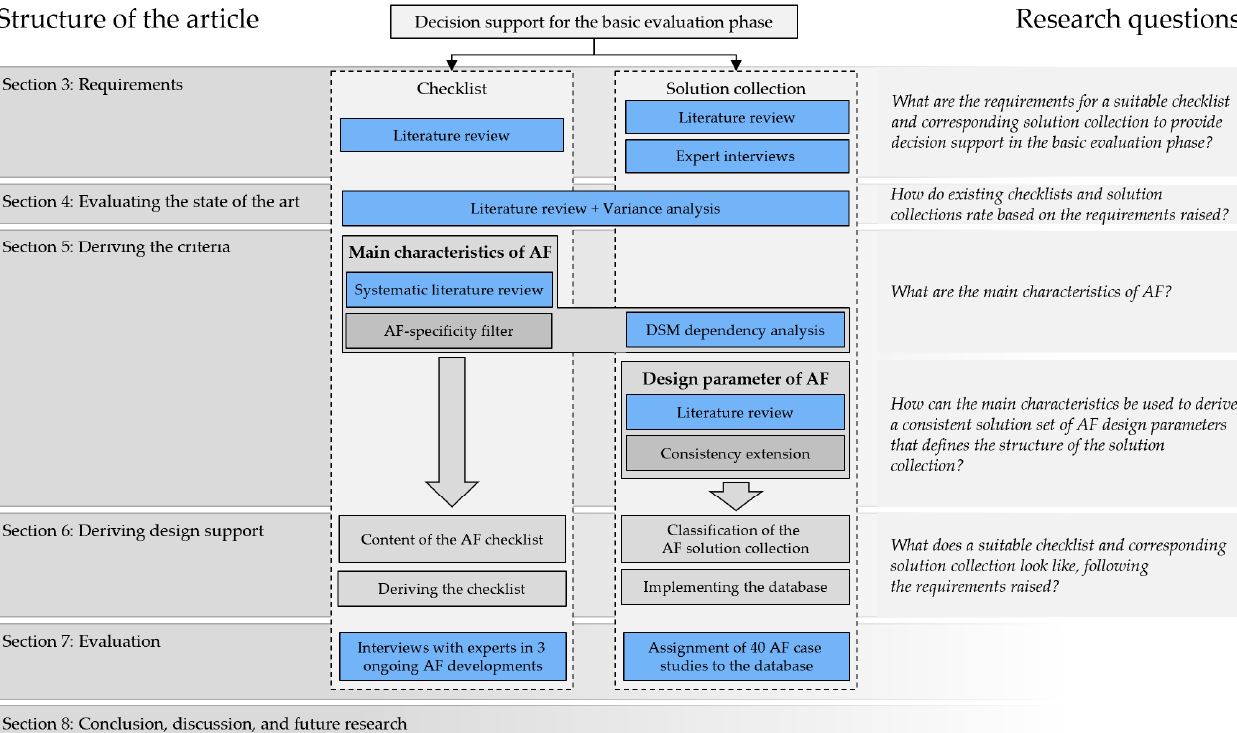
Figure 2. Structure of the article, research questions, and methodology—methods used are highlighted in blue.